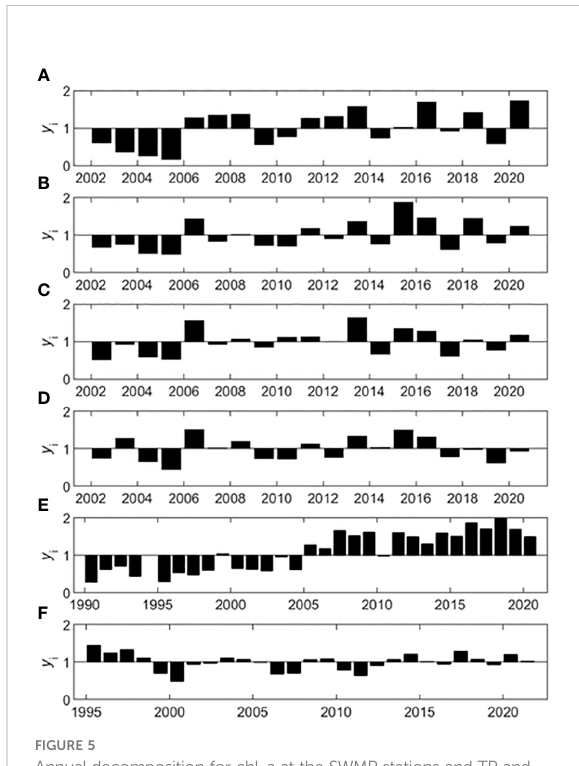
FIGURE 5 Annual decomposition for chl- a at the SWMP stations and TP and RBI at the gauge. The SWMP chl- a annual components ( y i , bars) are shown for the (A) Fish River, (B) Magnolia River, (C) Middle Bay, and (D) Weeks Bay stations. Gauge annual components ( y i , bars) are shown for (E) TP and (F)